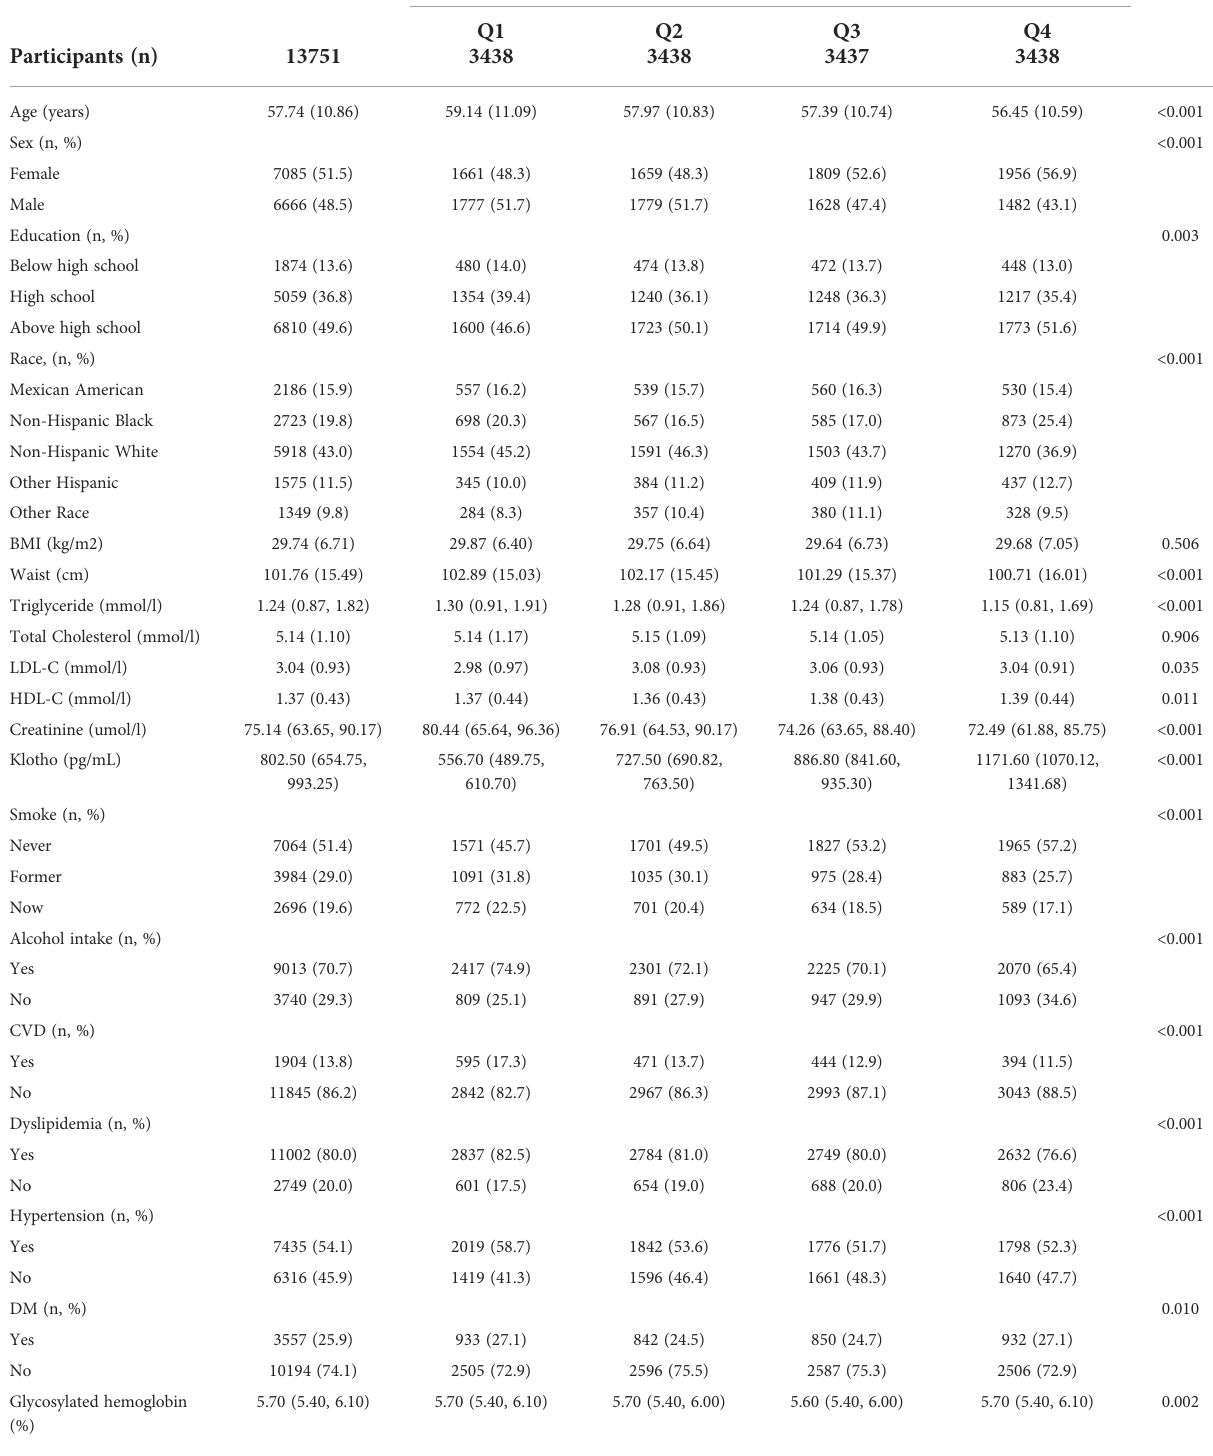
TABLE 1 Baseline characteristics of the study